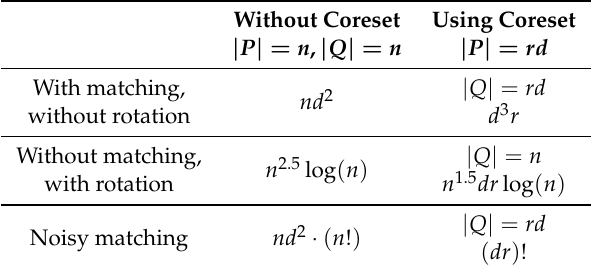
Table 1. Time comparison. All the numbers written in the table are in O notation and represent time complexity.